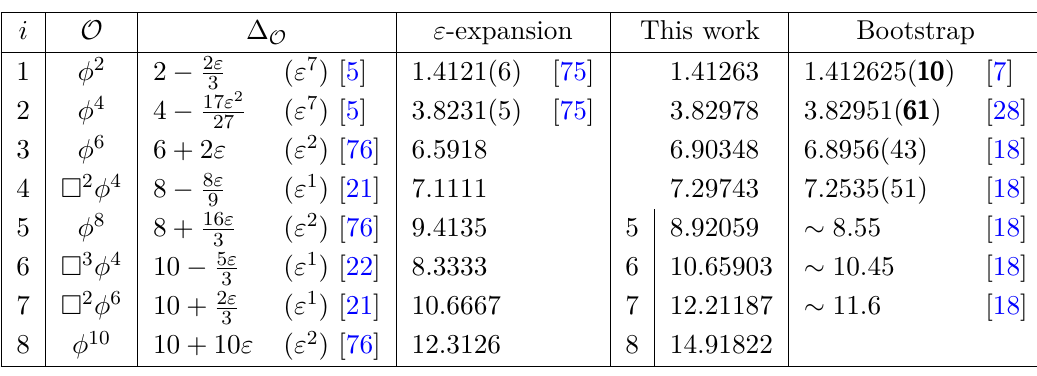
Table 1 . Z 2 -even scalars. The third column summarizes the known ε -expansion results while the fourth column refers to evaluations of various resummations at ε = 1 . Specifically, the evaluation of the hypergeometric-Meijer resummation for O ( ε 7 ) results, Padé and truncation for O ( ε ) results. The fifth column contains the dimensions found in this work at d = 3 . The last column contains know bootstrap results at d = 3 from previous works. The errors in bold refer to rigorous